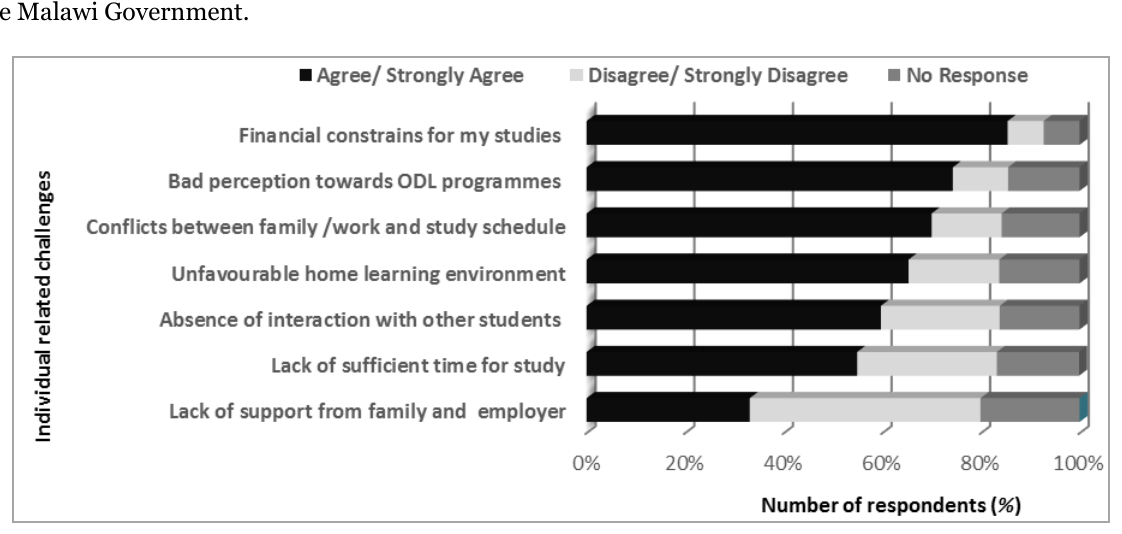
Figure 3. Challenges